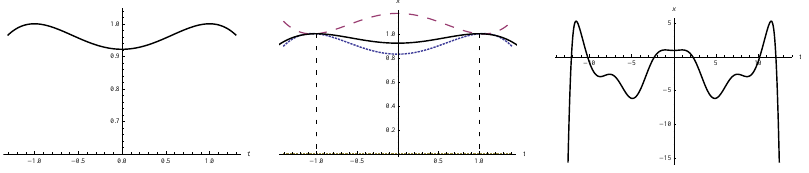
Figure 2. Solution of the problem (4.11).